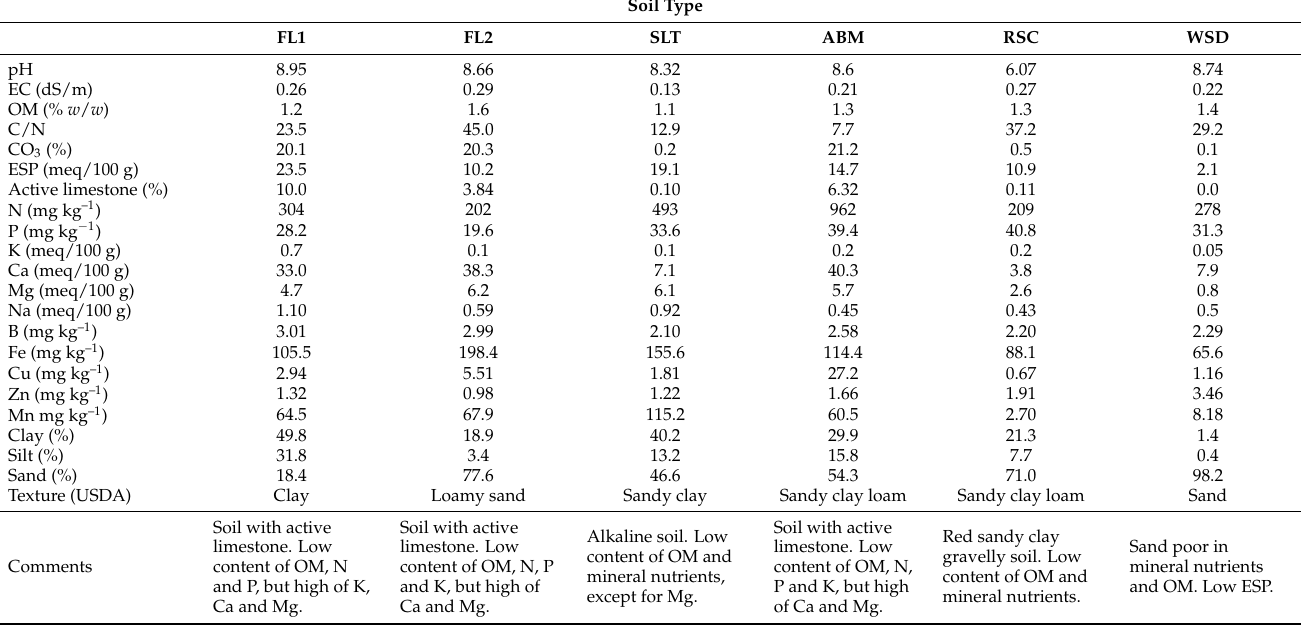
Table 12. Mean values of the physical–chemical properties of the upper soil layer in the study area. FL1 and FL2, soils from farmlands; SLT, soil on slates; ABM, soil on argillaceous blue marls; RSC, red sandy clay soil; WSD, forest soil on white sandy